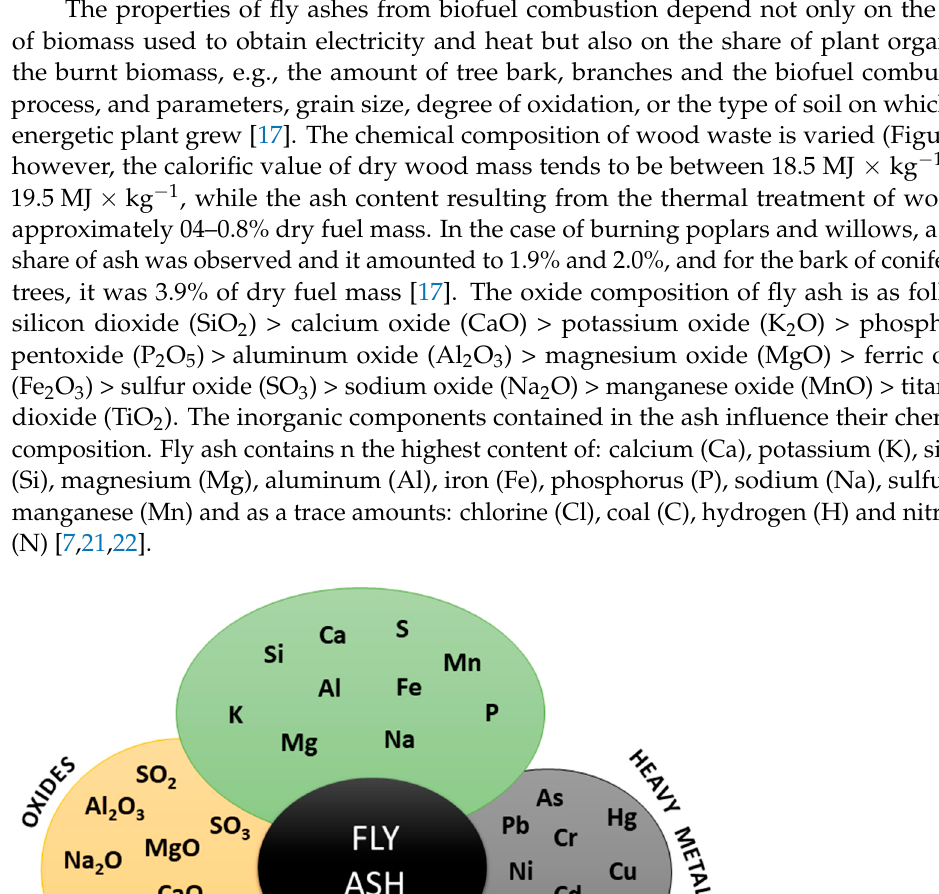
Table 1. Oxide composition of fly ashes from plants and wood biomass as well as energy plants combustion. Type of Fly